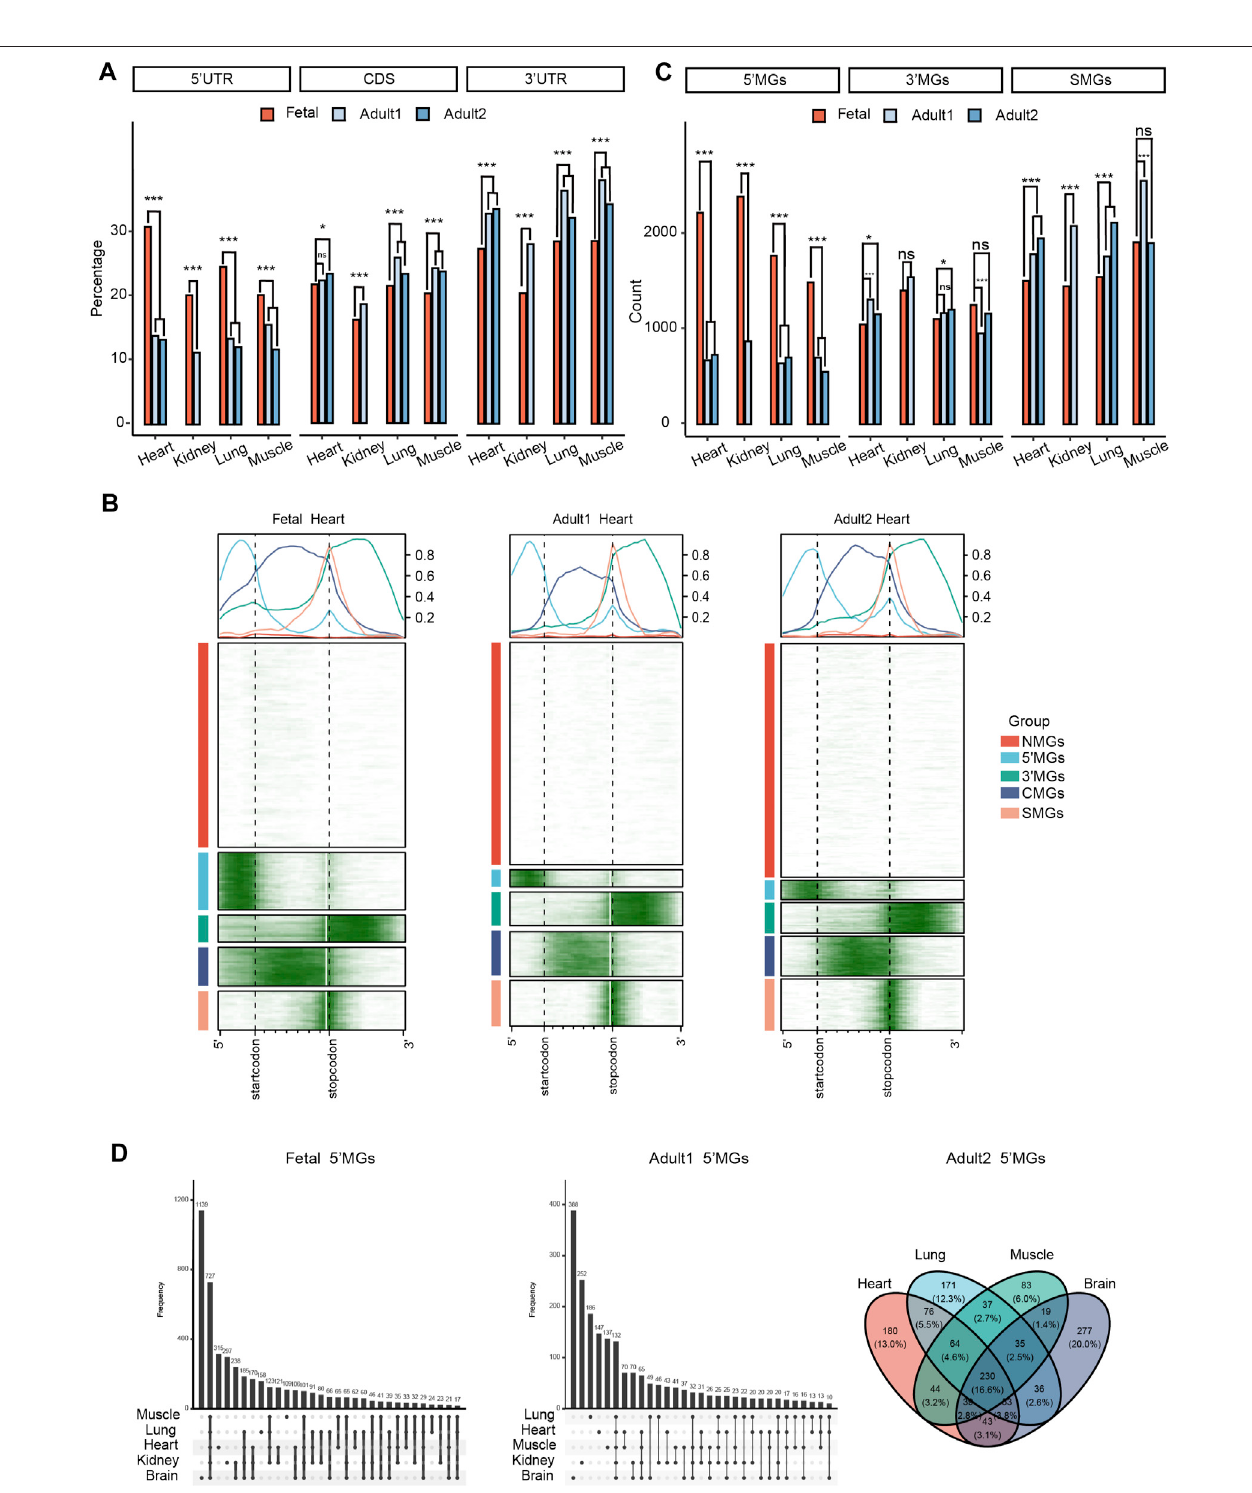
FIGURE1| Differentm6Atopologicalpatternsbetweenhumanfetalandadulttissues. (A) Thefrequencyofm6Aslocatedinthe5 ′ UTRs,CDS,and3 ′ UTRsamong human tissues in fetal and adult stages ( z -test , *** p value < 0.001, * p value < 0.05, ns: not signi fi cantly). Adult1 means the fi rst dataset of adult tissues and adult2 means the second datasets. (B) The m6A topological patterns along the m6A deposited regions in human fetal and adult heart tissues. We de fi ned those fi ve group genes as NMGs, 5 ′ MGs, 3 ′ MGs, CMGs, SMGs according tothe m6Adeposited regions. White colormeanswithoutm6A peak,greencolor means withm6A peak. (C) The frequencyof5 ′ MGs,3 ′ MGsandSMGsamonghumantissuesinfetalandadultstages( z -test,*** p value < 0.001,* p value < 0.05,ns:notsigni fi cantly). (D) Theoverlapof 5 ′ MGs across all fetal (left) and adult (right) tissues.